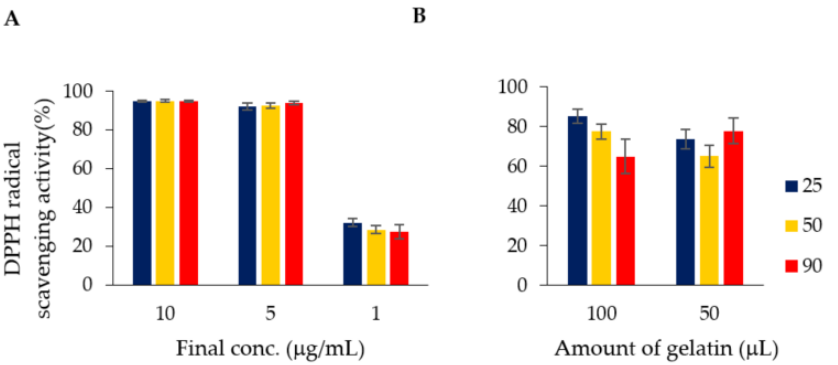
Figure 6. DPPH radical scavenging capacity of green tea extract solution ( A ) and green tea extract– adsorbed gelatin ( B ). The green tea extract ( A ) was measured at final concentrations of 10, 5 and 1 μ g/mL. For gelatin ( B ), measurements were performed with 100 and 50 μ L of gelatin. RT: Unheated green tea extract or green tea extract–adsorbed gelatin; 50 or 90 °C: Green tea extract or green tea extract–adsorbed gelatin pre-treated at the respective temperature (Blue: 25 °C; Yellow: 50 °C; Red: 90 °C).